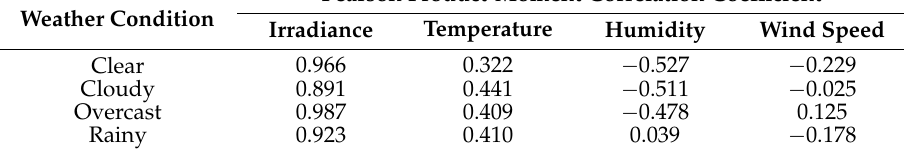
Table 2. Pearson product-moment correlation coefficient between PV output and environmental factors under typical weather